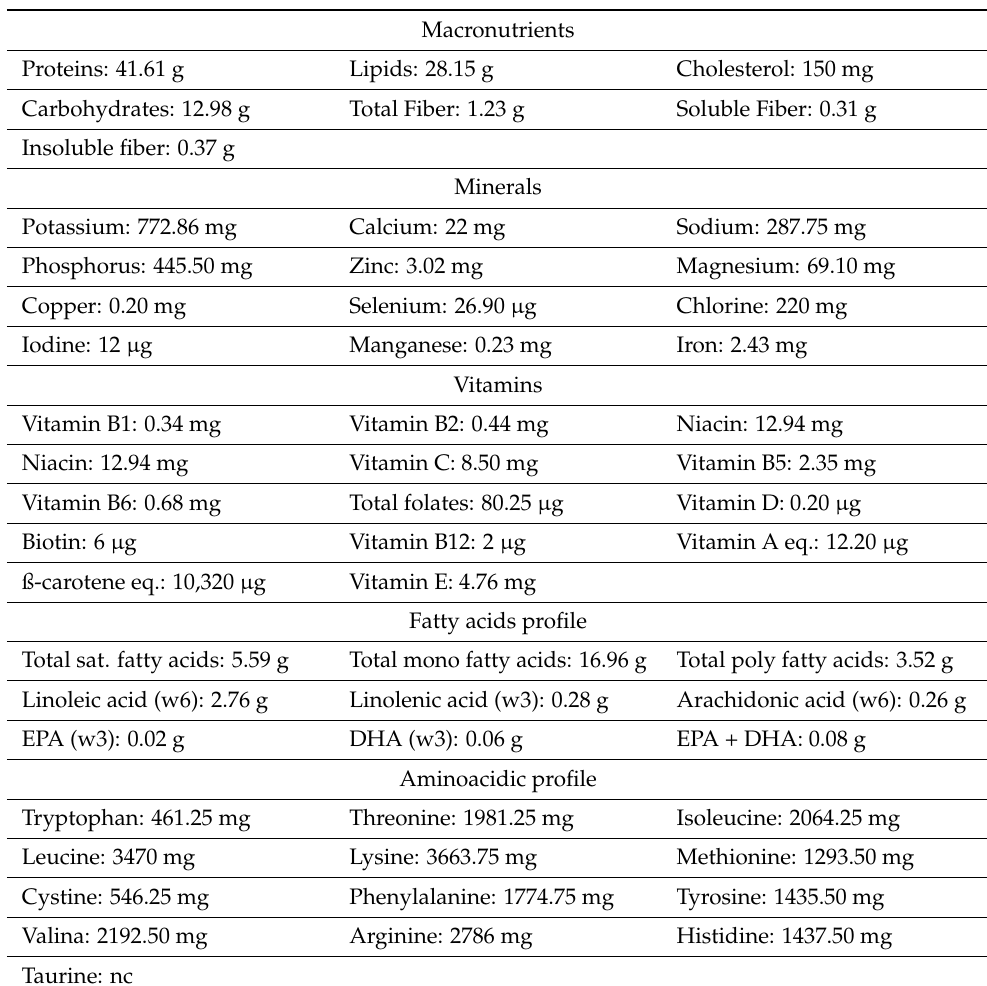
Table 3. Nutritional composition of the PRD, estimated by Myvetdiet© software. Data are provided on the total diet, as fed. Red text indicates nutrients whose intake is above or below minimum nutritional requirements according to [21,22].